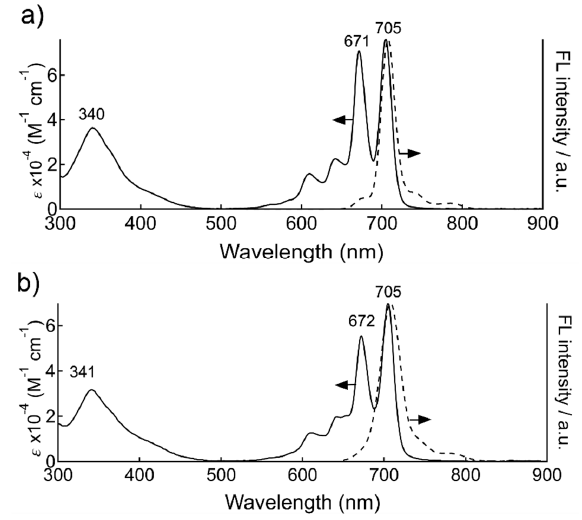
Figure 4. Absorption (solid line) and fluorescence (dashed line) spectra of 1 ( a ) and 2 ( b ) in CH 2 Cl 2 .